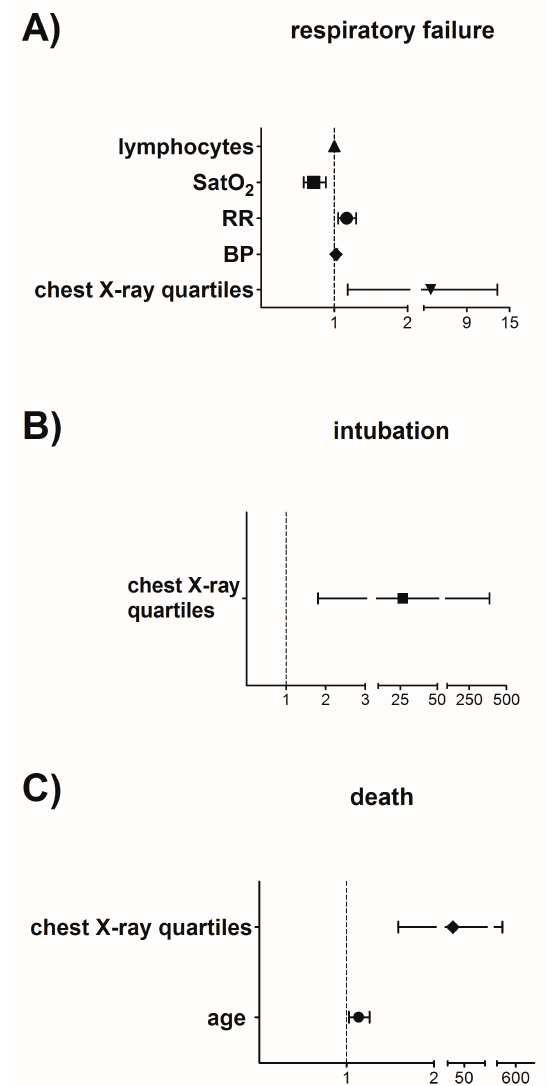
Figure 1. Multivariate analysis-Forest Plots. Statistically significant variables in univariate analysis were evaluated in a multiple logistic regression model with gender, age, body mass index (BMI), Charlson comorbidity index (CCI), and national early weaning score (NEWS) 2 treated as covariates, while progression to respiratory failure, intubation and death were considered as dependent variables: ( A ) involvement of all four chest X-ray quartiles ( p = 0.026), higher systolic blood pressure [mmHg, ( p = 0.041)], higher respiratory rate [breaths per min, ( p = 0.004)], lower SatO 2 [%, ( p = 0.002)] and lymphopenia [cells/ µ L, ( p = 0.026)] were independent risk factors of the development of respiratory failure; v ( B ) involvement of all four chest X-ray quartiles ( p = 0.017) was an independent predictor of intubation; ( C ) older age [years, ( p = 0.014)] and involvement of all four chest X-ray quartiles ( p = 0.021) were independent predictors of death. Calculated estimates are shown as odds ratios (OR), with 95% confidence intervals (CI). For quantitative variables, OR reflects changes per given unit. p -values < 0.05 were consider